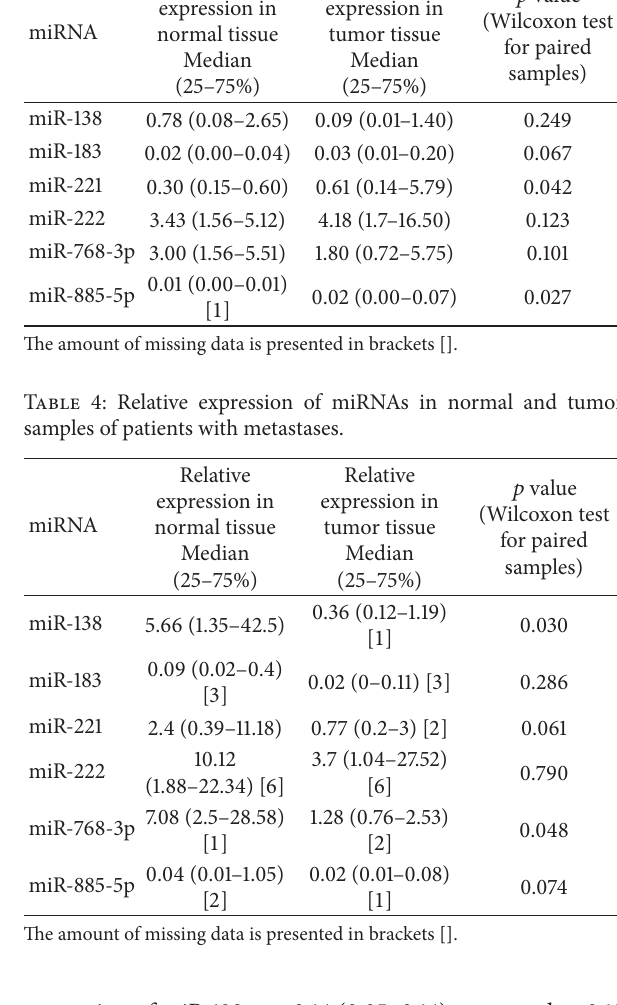
Table 1: Clinical, demographic, and histopathological characteris- tics of patients with H¨urthle cell thyroid carcinoma.